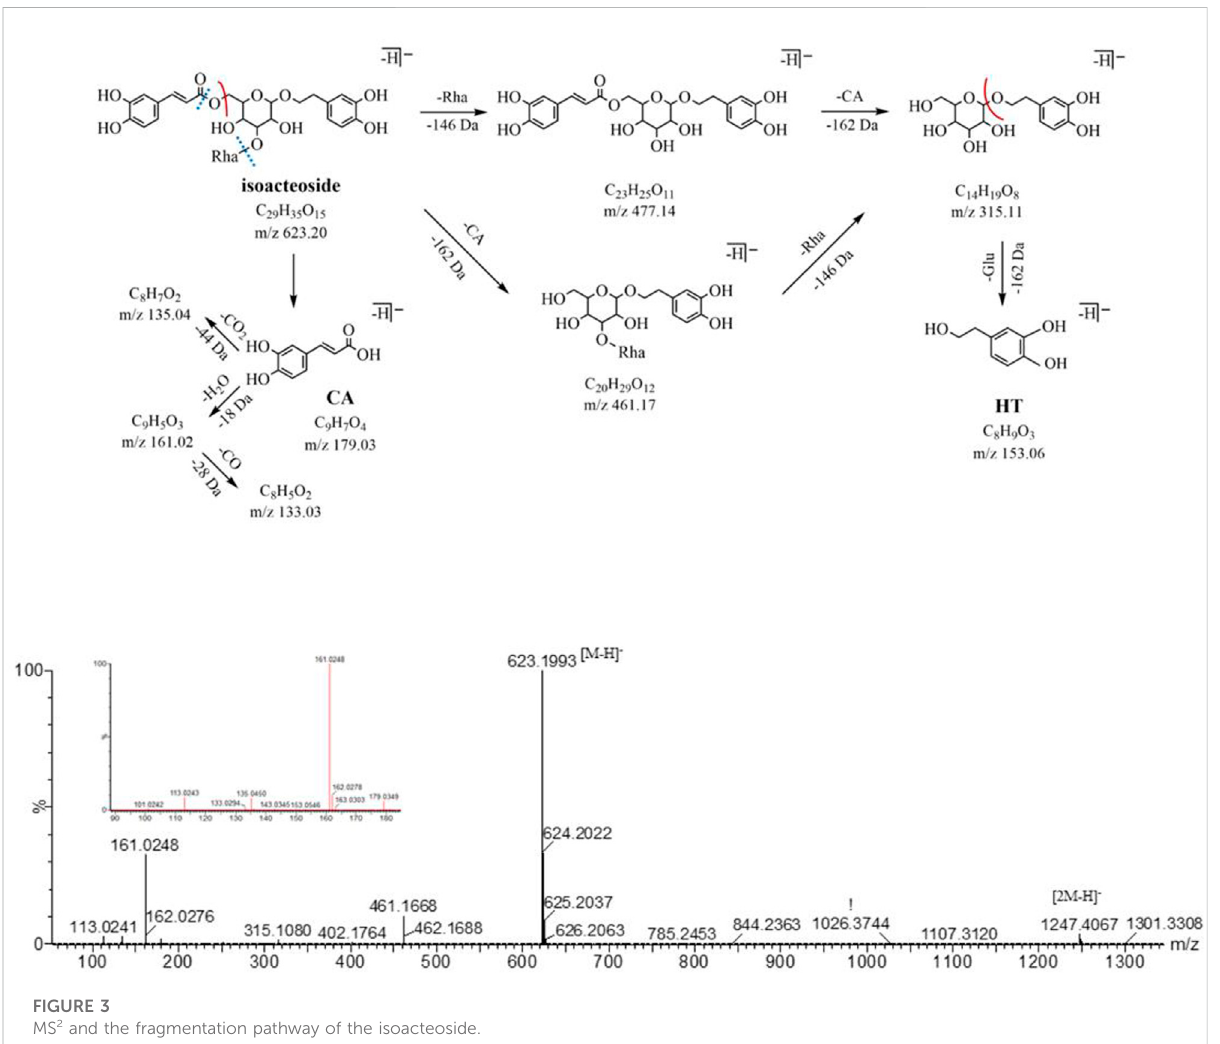
FIGURE 3 MS 2 and the fragmentation pathway of the